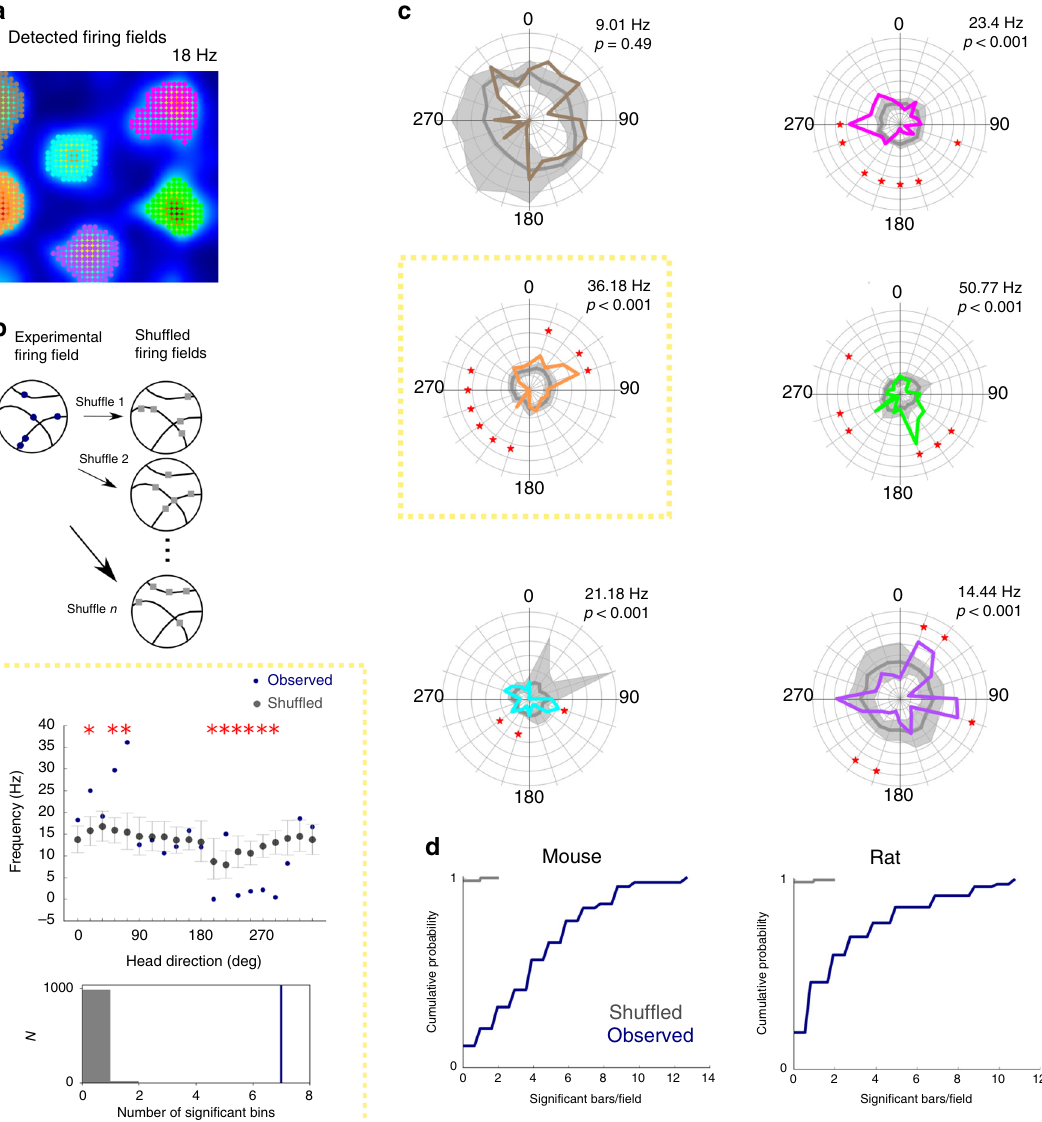
Fig. 3 Individual fi ring fi elds are modulated by head direction. a Firing rate map of the mouse grid cell from Fig. 1b with colour-coded automatically detected fi ring fi elds. b Schematic of shuf fl ing method (upper), example directional fi ring rate histogram for observed and shuf fl ed spikes (middle) for the highlighted fi eld from c (yellow box) and distribution of the number of signi fi cant bins from the shuf fl ed data (grey) and the observed data (blue) (lower). The error bars represent the 90% con fi dence interval of the shuf fl ed distribution and the measure of centre is the mean. Asterisks indicate bins in which the observed data differs signi fi cantly from the shuf fl ed data ( p < 0.05, two-tailed p value calculated from the shuf fl ed distribution and corrected for multiple comparisons with the Benjamini – Hochberg procedure). c Distributive plots for each fi ring fi eld (coloured according to a , fi eld in yellow box also shown in b ). The maximum fi ring rates are shown above the head direction plots. Signi fi cantly directional bins ( p < 0.05, two-tailed p value calculated from the shuf fl ed distribution and corrected for multiple comparisons with the Benjamini – Hochberg procedure) are marked with an asterisk (*). d The number of directional bins (out of 20 bins) that differ signi fi cantly (threshold p < 0.05 after correction for multiple comparisons) from the shuf fl ed data. The numbers of signi fi cant bins differed between observed and shuf fl ed data (mice: n = 44 fi elds from 13 grid cells, p = 5.1 × 10 − 23 , U = 9.88, rats: n = 83 fi elds from 25 grid cells, p = 1.2 × 10 − 18 , U = 8.81, two-sided Mann – Whitney U